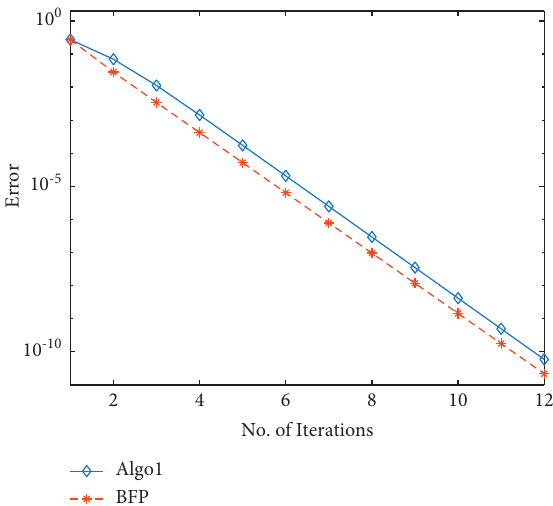
Figure 2: CPU time graph and iteration vs error Fig 17 : CPU time Fig 18 : it . no . vs . error Fig 19 : Sols surface plot ′ Fig 20 : CPU time Fig 21 : it . no . vs . error Fig 22 : Sols surface plot ′ Fig 23 : CPU time Fig 24 : it . no . vs . error Fig 25 : Sols surface plot ′